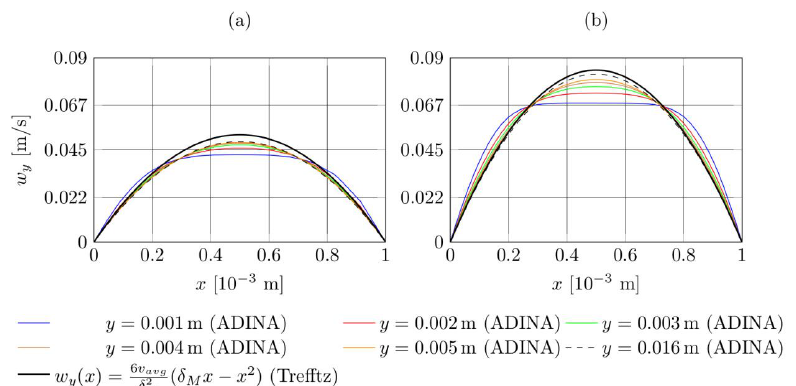
Figure 6. Distributions of the y -component of the fluid velocity vs. the distance from the adiabatic wall of the minichannel, obtained from computations in ADINA software (at six distances along the flow) and assumed in calculations based on the Trefftz functions; ( a ) the test section with three minichannels, q’’ = 68 kW/m 2 , ( b ) the test section with five minichannels, q’’ = 13.8 kW/m 2 . The relative difference between the maximum values of w y for the test section with three minichannels (see Figure 6a) obtained from ADINA at y = 5 mm and from the computations using the Trefftz functions was equal to 7.3%, while at y = 16 mm it was less than 6.6%. Moreover, the relative difference values turned out to be smaller for the test section with five minichannels (see Figure 6b): at y = 5 mm the difference achieved 5.5%, whereas at y = 16 mm it was less than 2.5%.